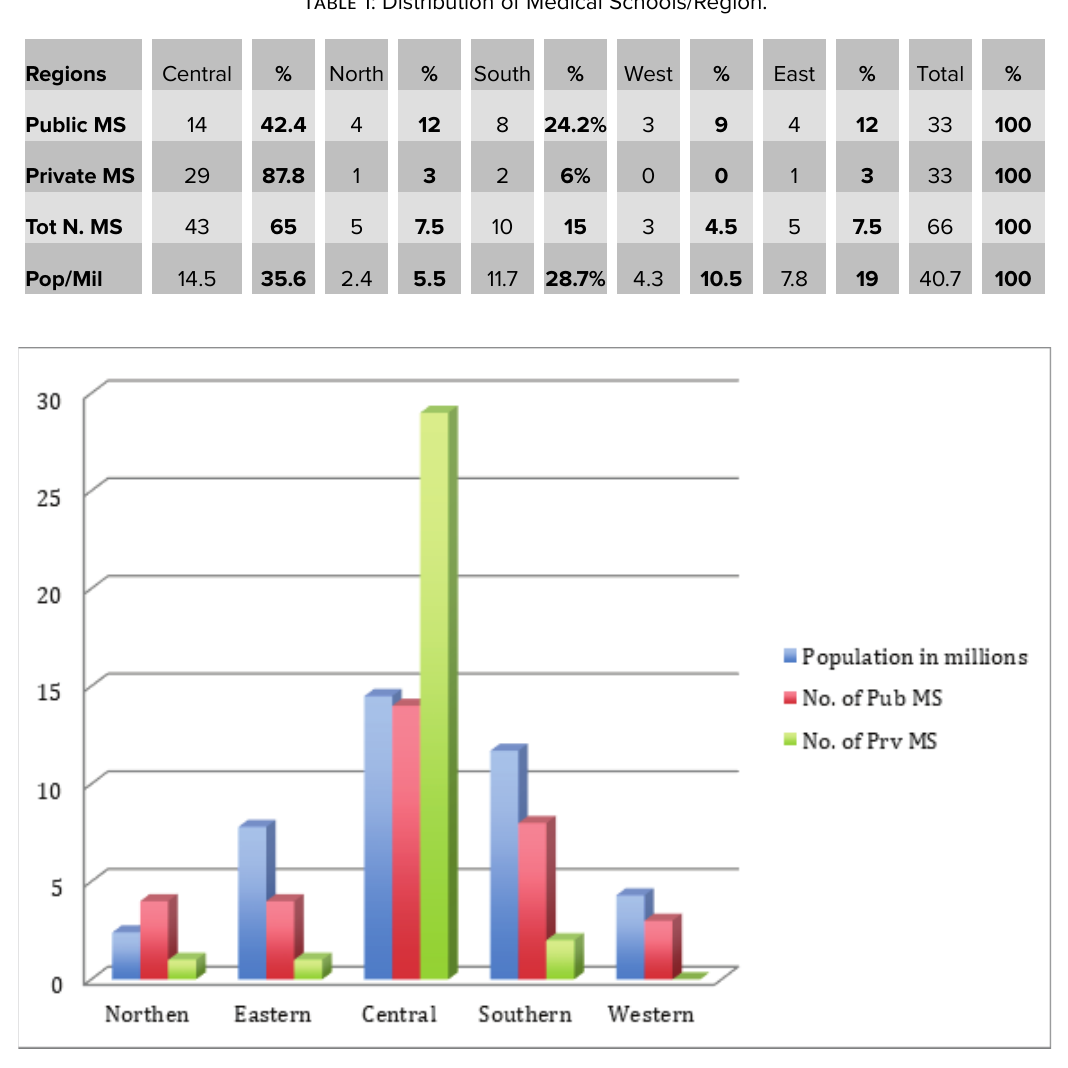
Figure 3: The distribution of Medical Schools according to their types and Sudan Regions